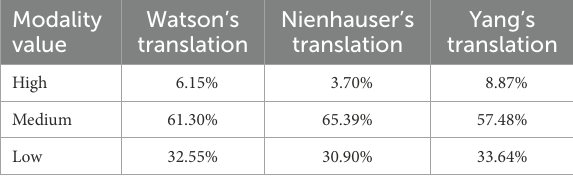
TABLE 8 The distribution of modality values in the three